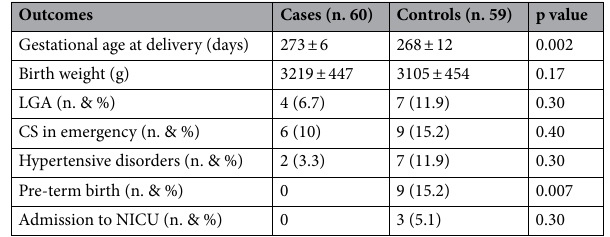
Table 4. Clinical outcomes. LGA large for gestational age, CS caesarean section, NICU neonatal intensive care unit.